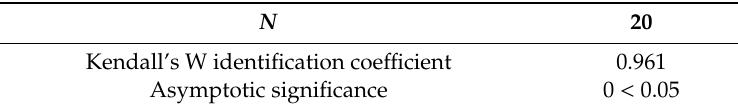
Table 1. Verification statistics of tools.